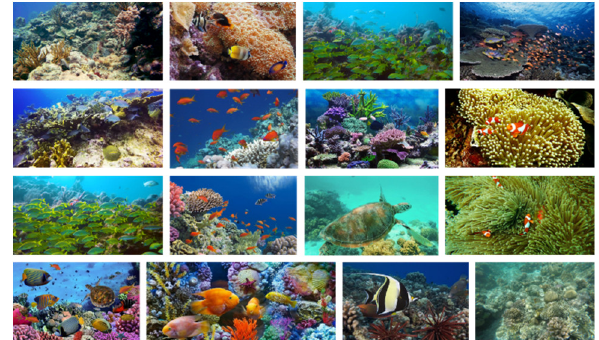
Figure 3 . Example images from the dataset.